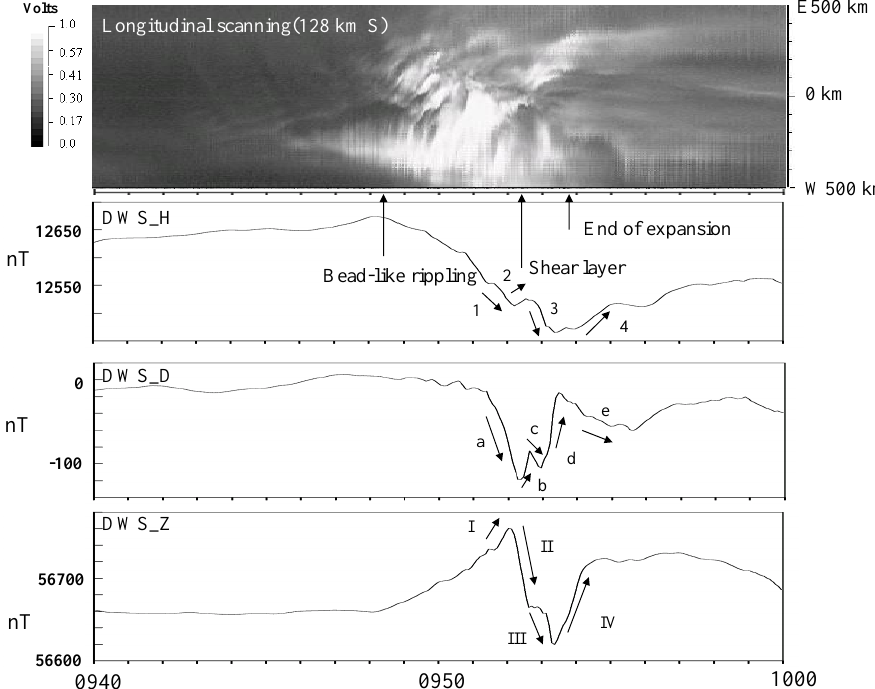
Figure 8. From top to bottom: 20min plots of longitudinal scanning along the equatorward arc (128km south of DWS), the H component of the DWS magnetogram, the D component for DWS, and the Z component for DWS. The onset of the bead-like rippling, the onset of the multiple shear layers, and the end of the poleward expansion in the auroral display are shown by vertical arrows. The arrows labeled 1 to 4 for H , a to e for D , and I to IV for Z in the second, third, and fourth panels, respectively, denote characteristic changes of the field line vectors associated with the passage of the ionospheric loop current (see text). The aurora gray level is plotted to the